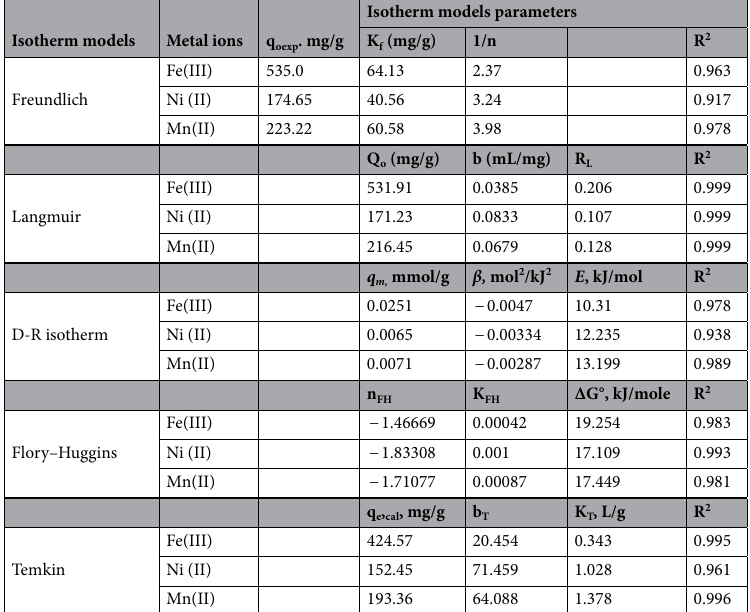
Isotherm models